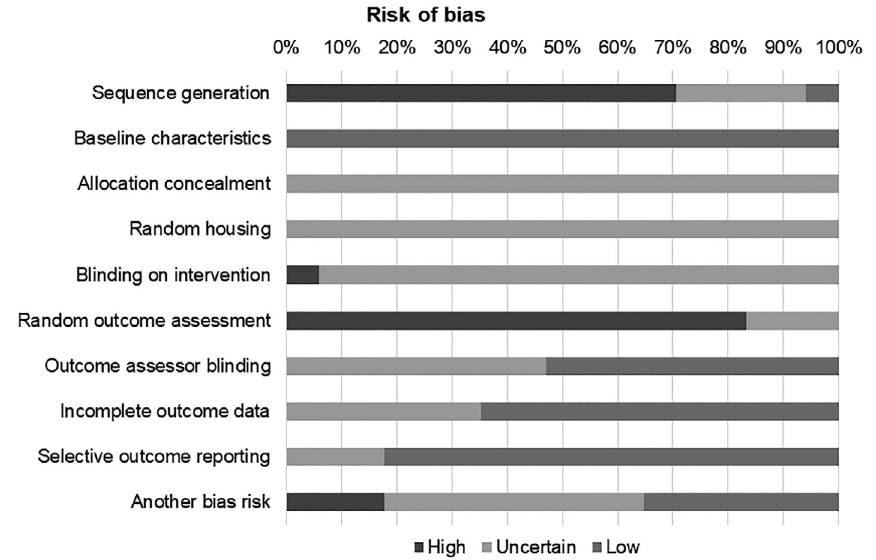
Figure 4- Risk of bias of the selected